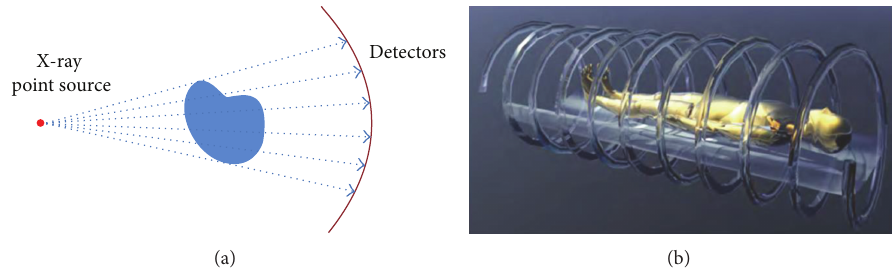
Figure 1: (a) Schematic of macrotomography used in medical examinations; (b) helical body scanning [17].